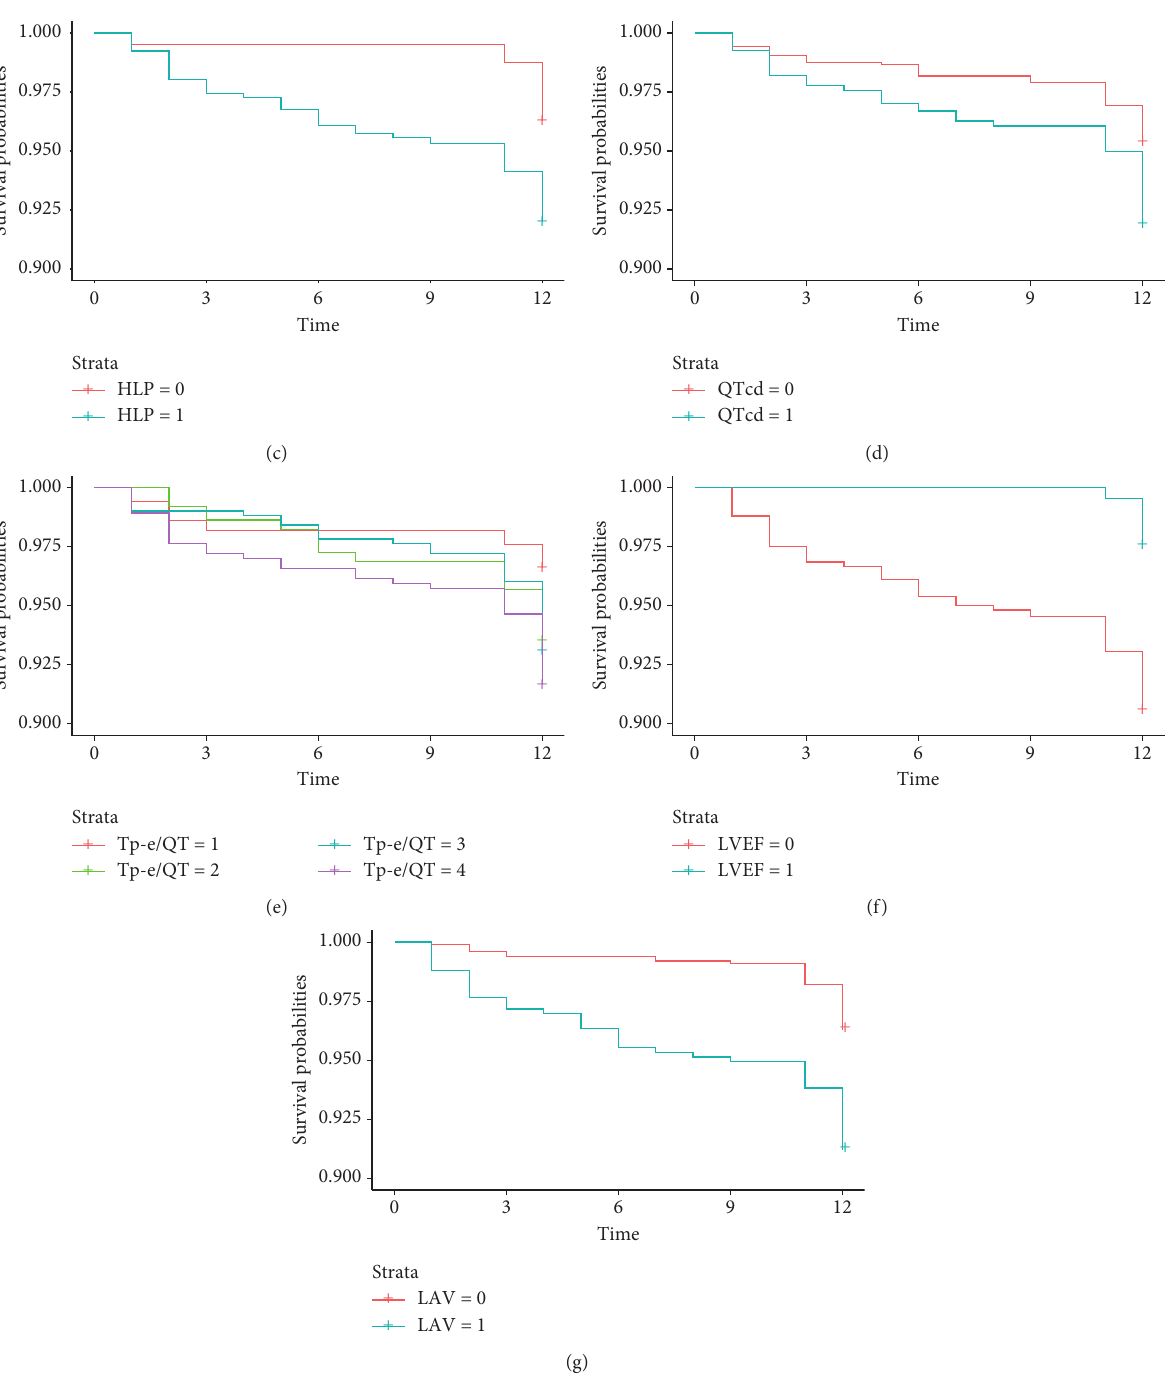
Figure 2: Cumulative survival function curves of each classified variable (a)–(g). Indexes are grouped by median (d, f, g). (a) Cumulative survival function curve of gender. (b) Cumulative survival function curve of age. (c) Cumulative survival function curve of HLP. (d) Cumulative survival function curve of QTcd. (e) Cumulative survival function curve of Tp-e/QT. (f) Cumulative survival function curve of LVEF. (g) Cumulative survival function curve of